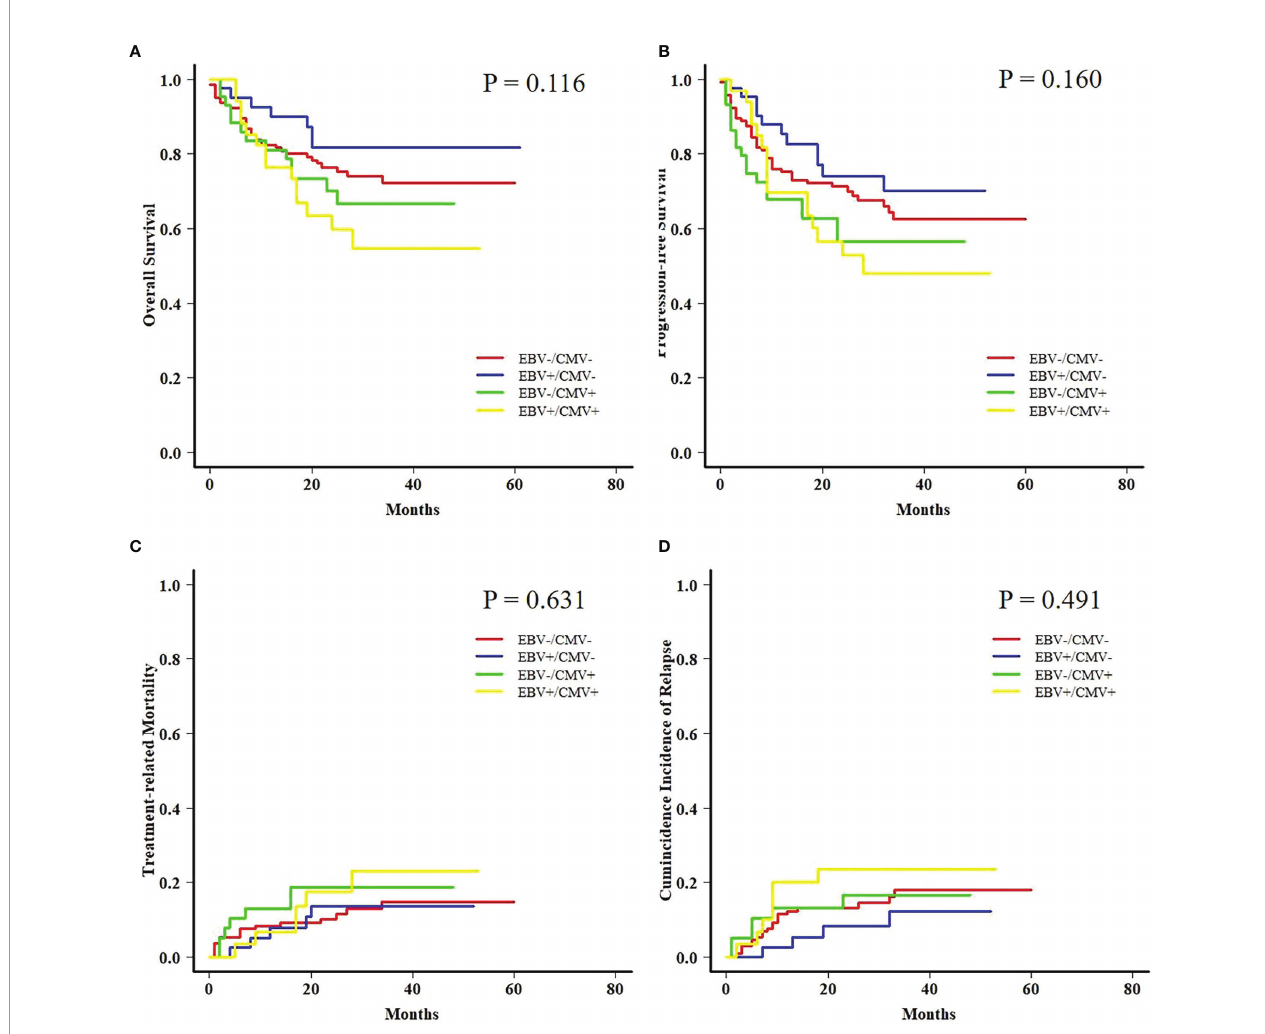
FIGURE 2 | Transplant outcomes among subgroups based on viral reactivation in acute lymphoblastic leukemia (ALL) patients. (A) OS among subgroups based on viral reactivation in ALL patients. (B) PFS among subgroups based on viral reactivation in ALL patients. (C) TRM among subgroups based on viral reactivation in ALL patients. (D) CIR among subgroups based on viral reactivation in ALL patients.